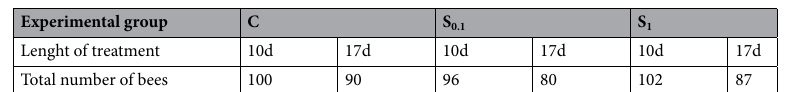
Table 2. Overview of experimental groups formed for molecular analysis with total number of bees per group; C-control, fed with 50% (w/v) sucrose as basic feeding solution, in S0.1 and S1 groups food was supplemented with 0.1 and 1 mM spermidine; treatment lasted for 10 and 17 days (10d and 17 d, respectively).